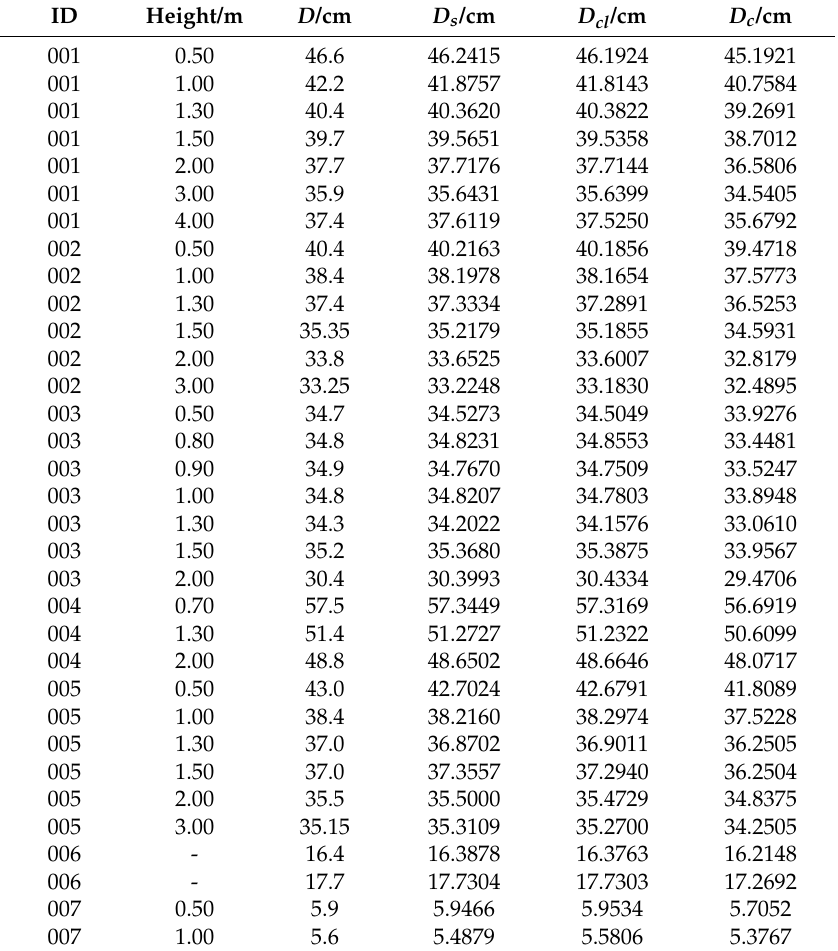
Table 3. Diameter values calculated using different